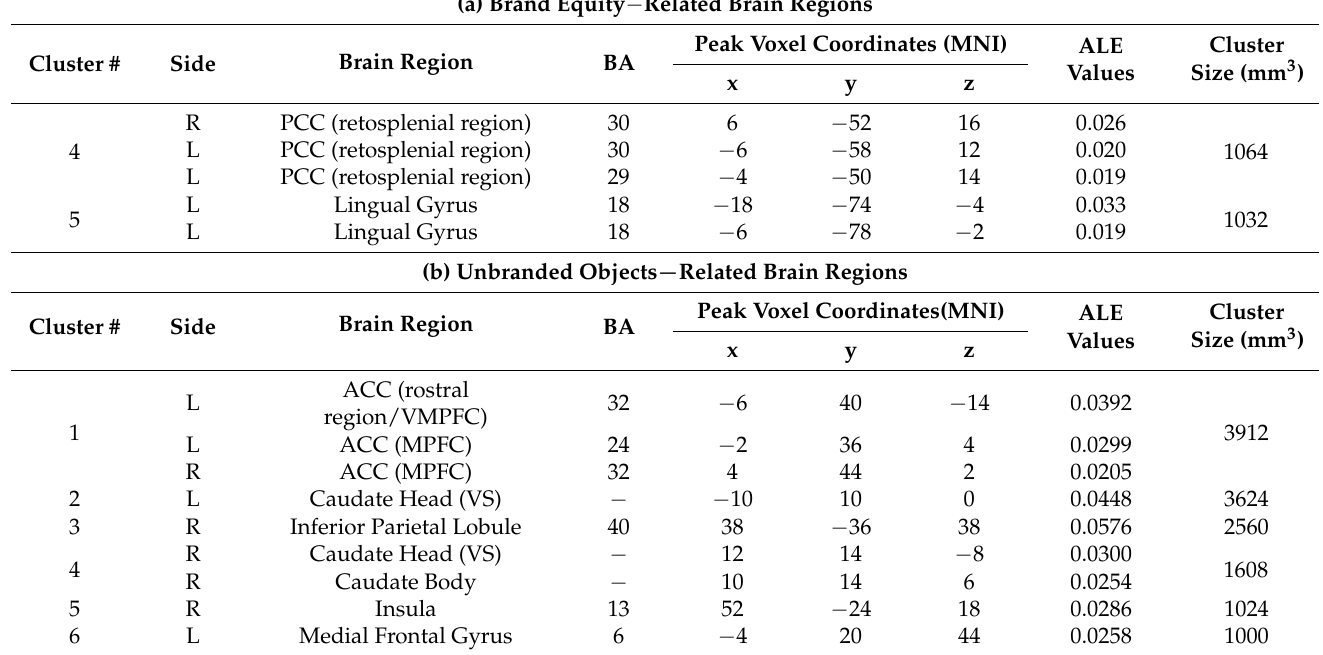
BA: Brodmann Area; MNI: Montreal Neurological Institute; ALE: activation likelihood estimation; L: left; R: right; ACC: anterior cingulate cortex; VMPFC: ventromedial prefrontal cortex; MPFC: medial prefrontal cortex; PHG: Parahippocampal Gyrus; VS: ventral striatum; PCC: posterior cingulate cortex.